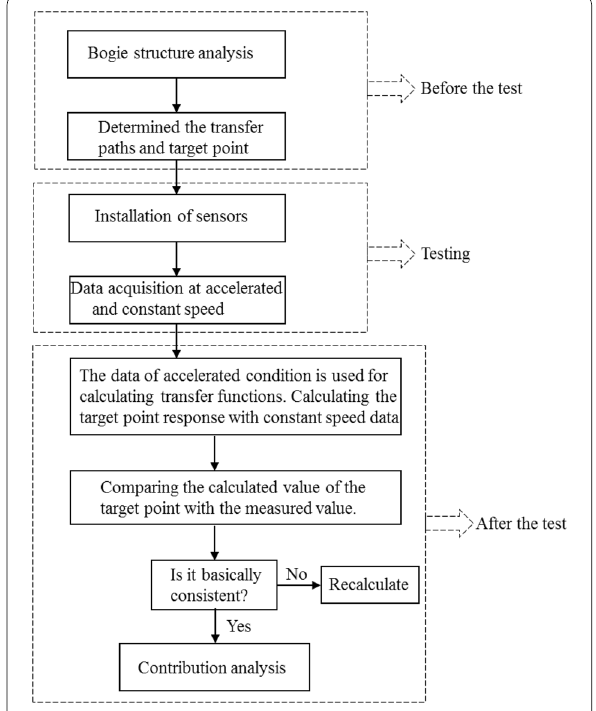
Figure 5 Flow chart of transfer path analysis